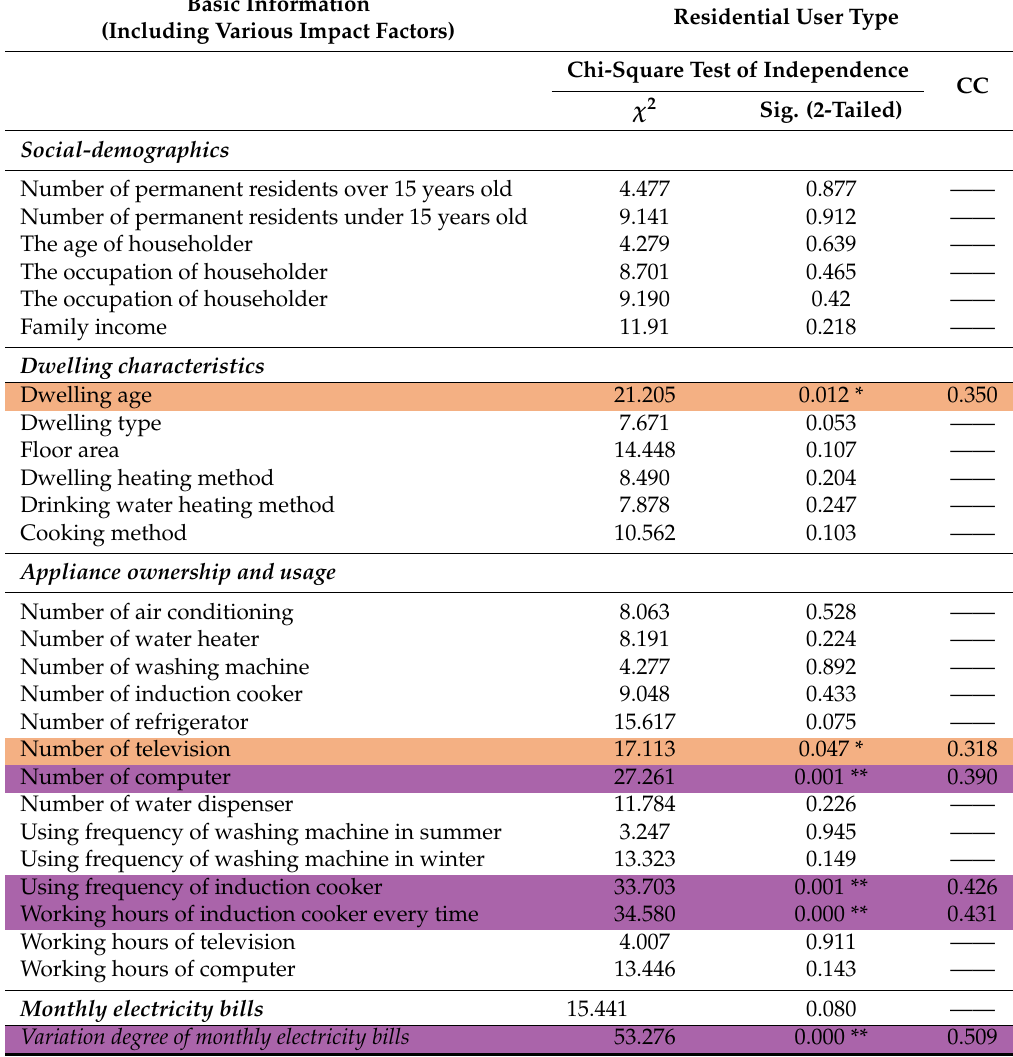
Table 3. Overview of Chi-Square Test of Independence and consistency coefficient values between basic information and residential user